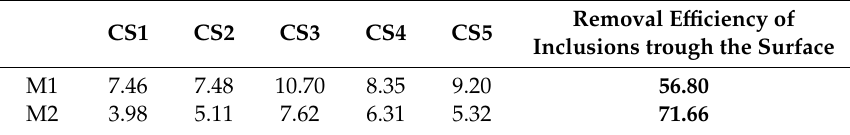
Table 9. Comparison of percentage proportions of inclusions removed through the surface and torn down into individual nozzles of casting strands for the variants with M1 and M2 and considering the distribution of inclusions of all sizes and densities as shown in Tables 4 and